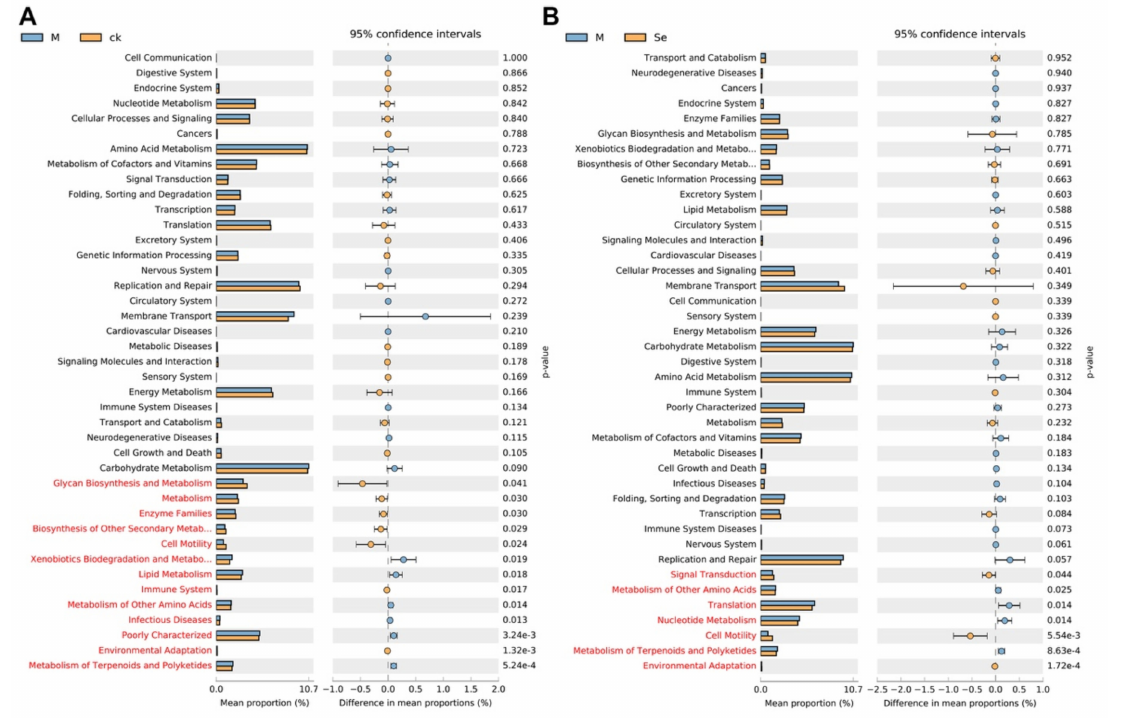
Figure 6. Effects of SeMet on the predicted functions of gut microbiota. ( A ) Differential predicted functions between the control (CK) group and the model (M) group. ( B ) Differential predicted functions between the M group and the SeMet (Se) group. Statistically differential predicted functions are marked in